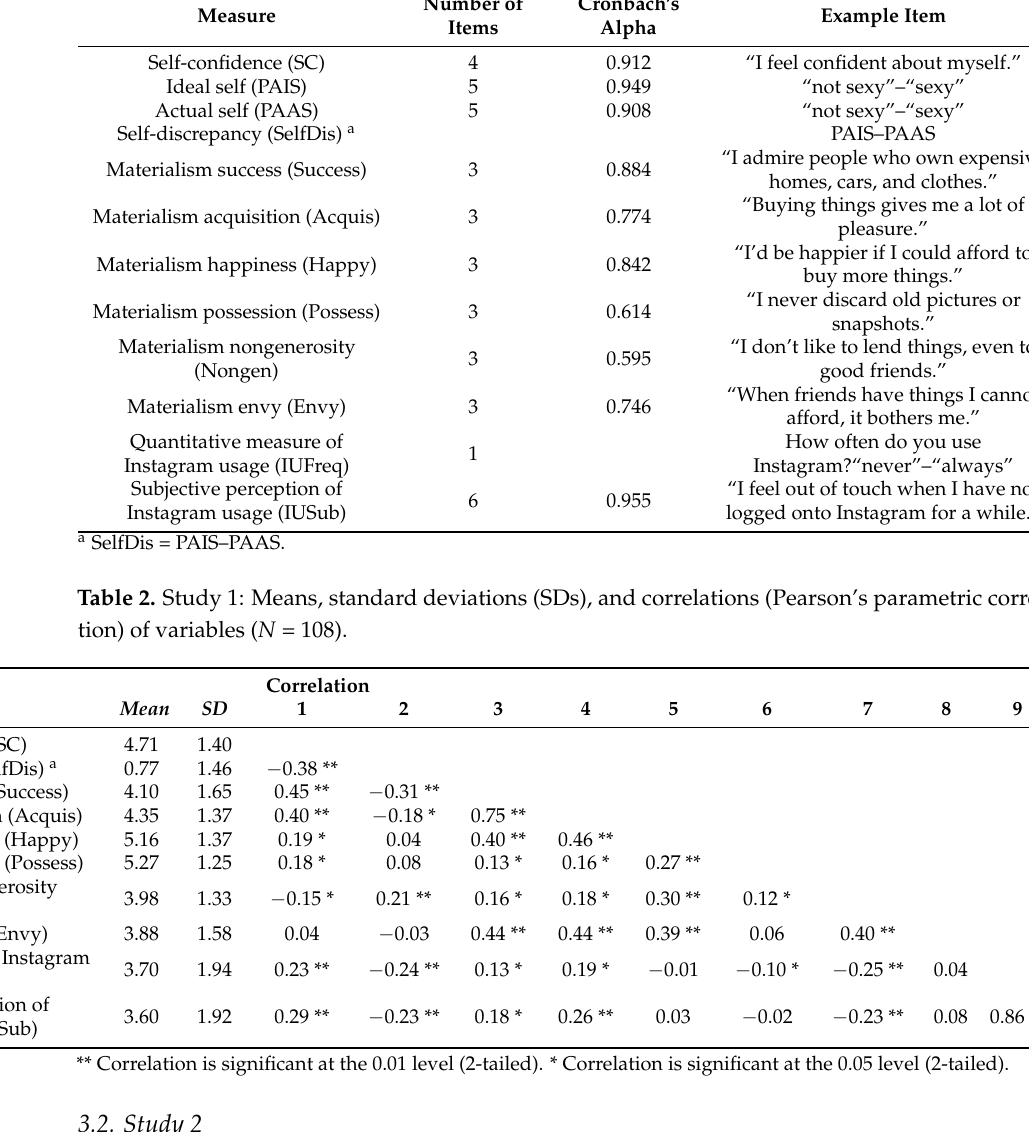
Table 1. Study 1: Number of items, Cronbach’s alpha, and an example item for each measure. Measure